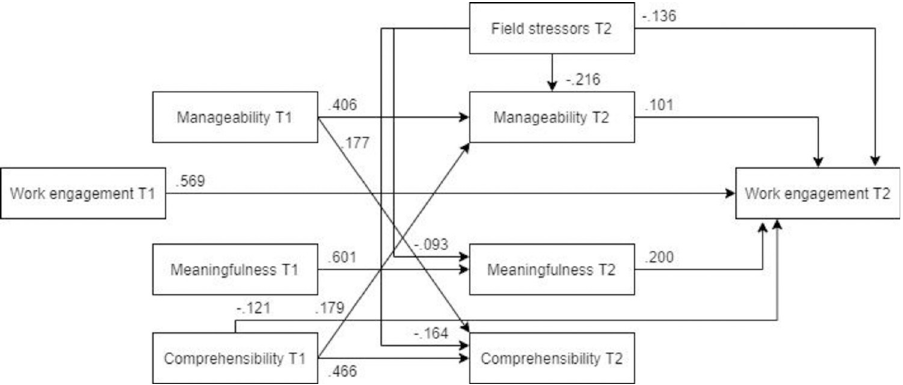
Fig 19. Optimized structural equation model of work